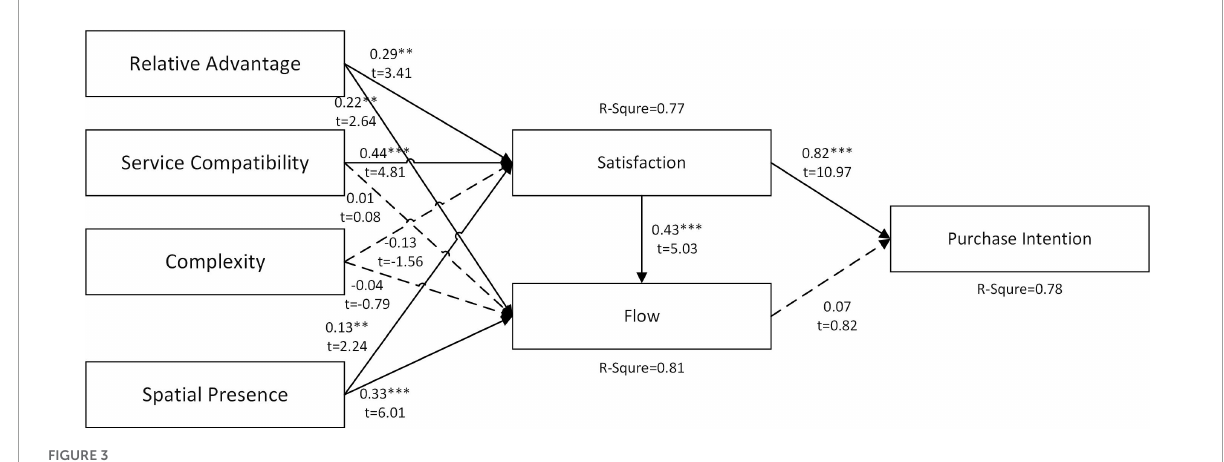
FIGURE3 Results for men samples. *** P < 0.001, ** P < 0.01, * P < 0.05, ns – not